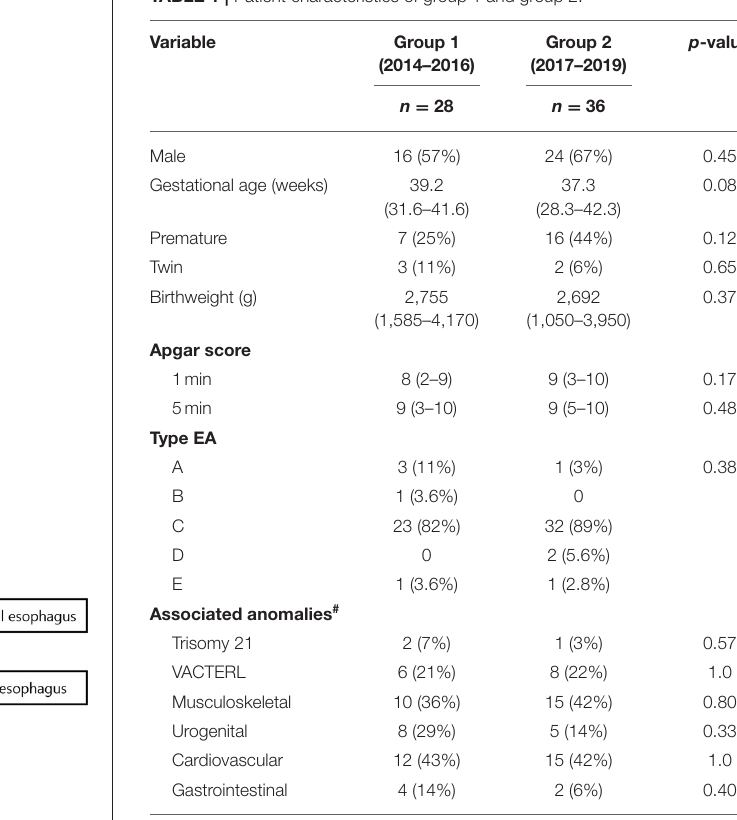
FIGURE 2 | After performing the tracheopexy, the proximal and distal esophagus are anastomosed.